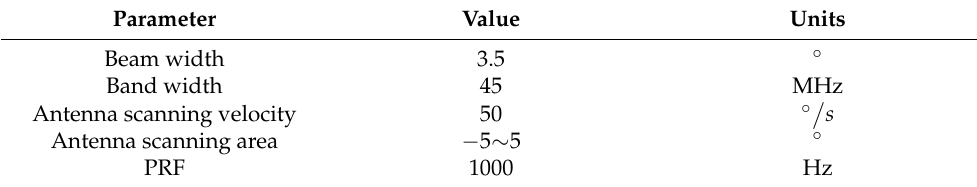
Table 2. System parameters of